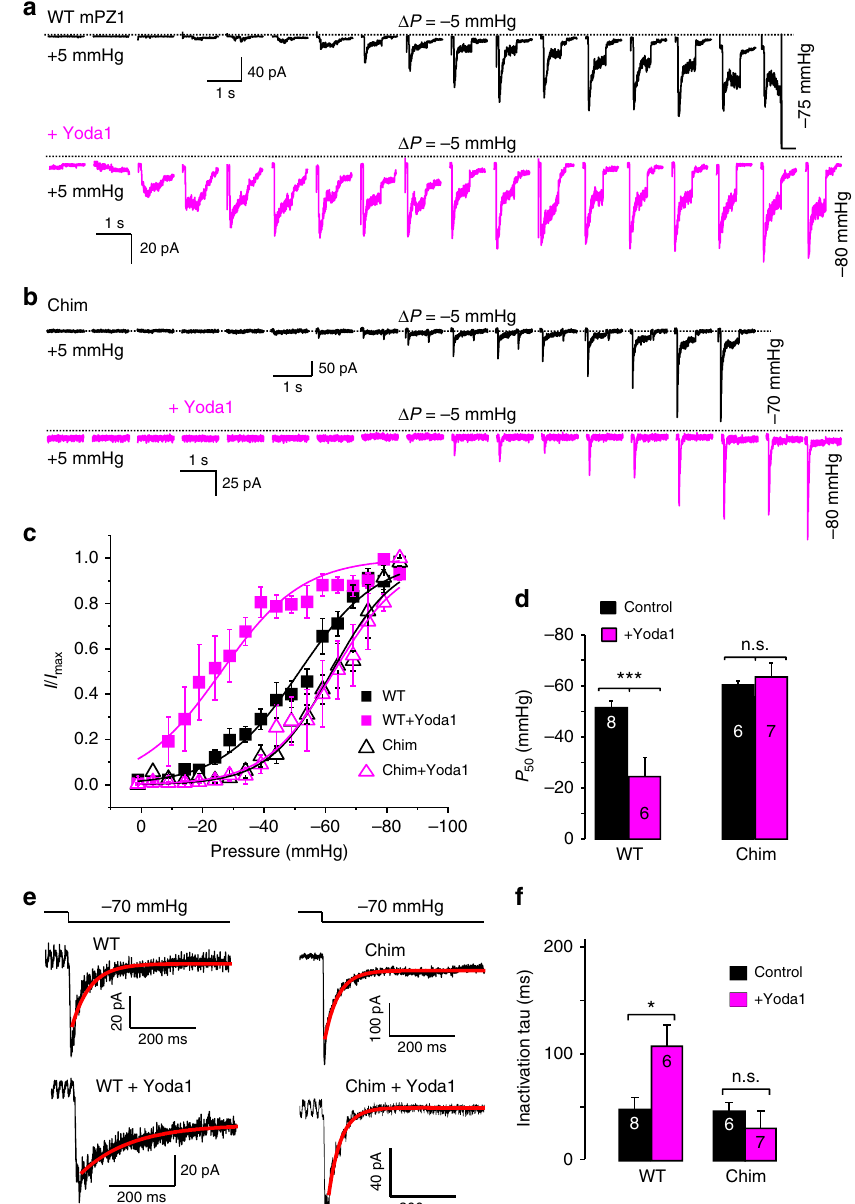
Fig. 2 The Piezo chimera 1961 – 2063 is not modulated by Yoda1. a , b Representative family of pressure-evoked current traces recorded in the cell-attached con fi guration for WT mPZ1 ( a ) or the chimera 1961 – 2063 (Chim) ( b ) in the presence (magenta traces) or absence (black traces) of 30 µ M Yoda1 in the patch pipette. Dotted lines indicate zero current level. c Normalized peak current plotted as a function of the pressure pulse for WT mPZ1 (full squares) and Chim (open triangles) in the presence (magenta squares and triangles) or absence (black squares and triangles) of 30 µ M Yoda1. The traces correspond to a fi t with Eq. 1. The plots correspond to the average of at least 5 independent recordings. d Histogram showing average P 50 values for WT and Chim in presence (magenta bars) or absence (black bars) of 30 µ M Yoda1. e Example of curve fi tting of decaying currents for the indicated constructs and pressure pulse using a monoexponential decay function. f Histogram showing the fi tted inactivation time constant (tau) for WT and Chim in presence (magenta) or absence (black) of 30 µ M Yoda1. For all electrophysiology data, V = − 80 mV. The number in each histogram indicates the number of independent traces analyzed. For each histogram, a Student t -test was used to test if the presence of Yoda1 signi fi cantly changes P 50 or tau: n.s. non-signi fi cant; ***: p < 0.001***: c , d and f error bars =